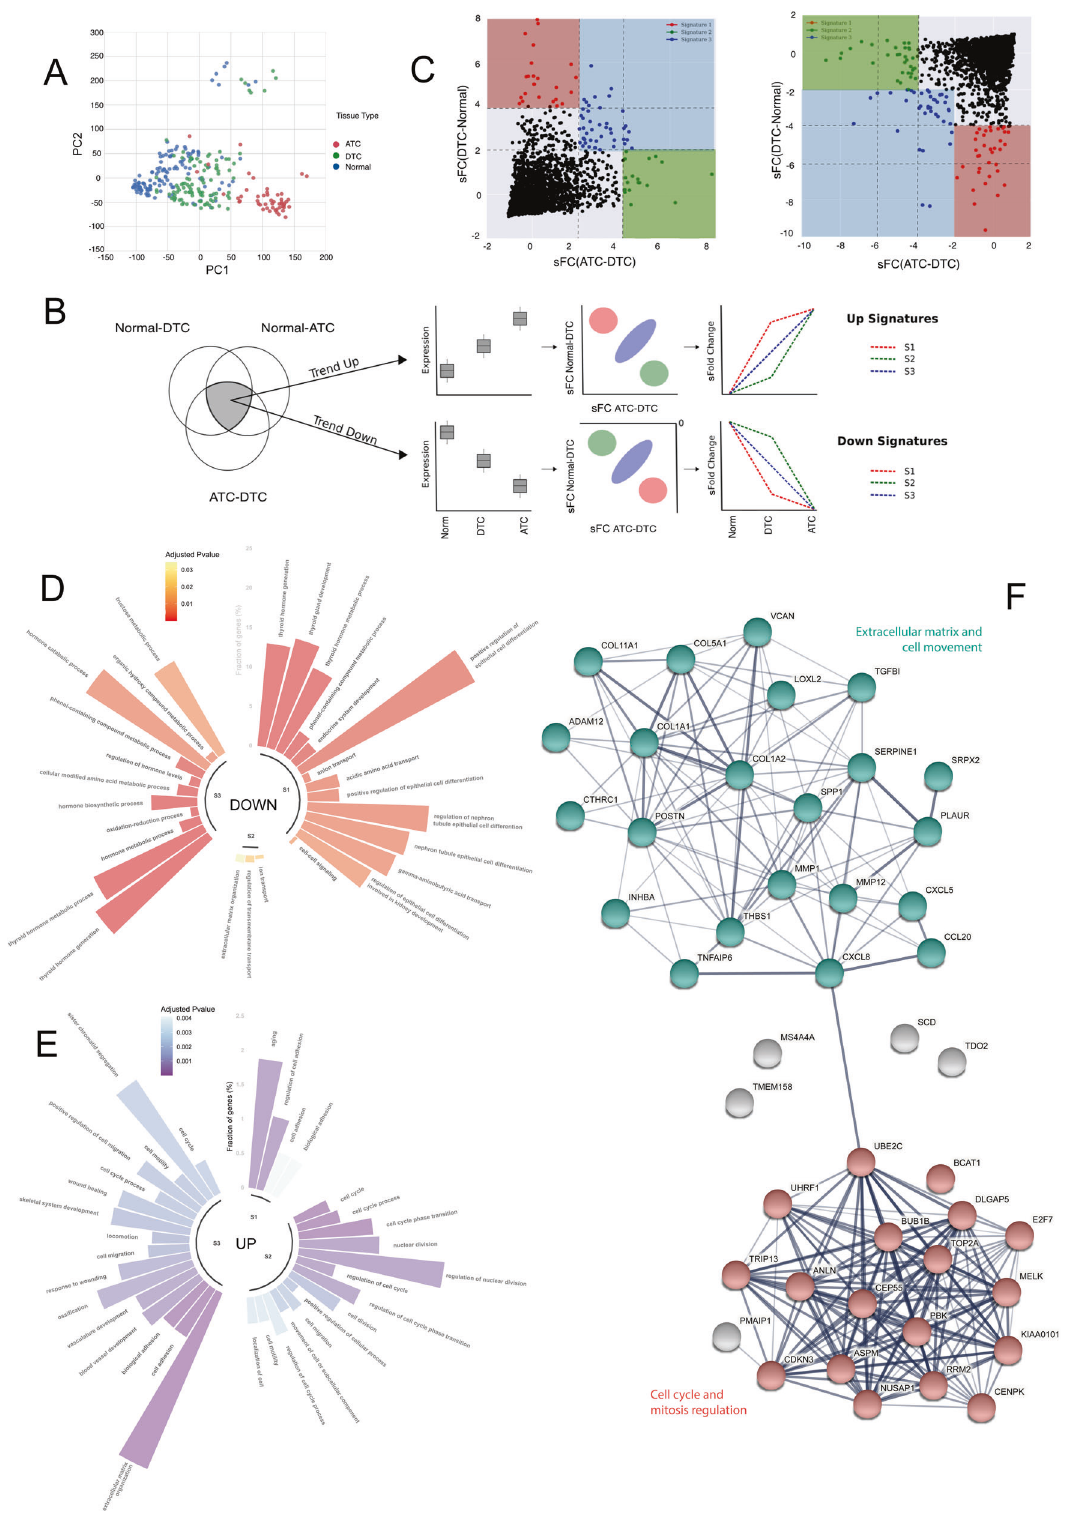
E2F7 putative target genes. Many known E2F7 target genes were present, such as CDC6 , E2F1, EZH2 and FEN1 , supporting the speci fi city of our analysis [18, 24] (Fig. 4C). RNA-sequencing analysis on E2F7 KD and control (CTRL) cells was conducted in both cell models (Cal-62 and 8505c) to sort among the list